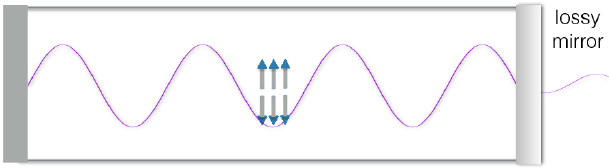
Figure 4: Modified setup without measuring photon output. This is equivalent to tracing over photon degrees of